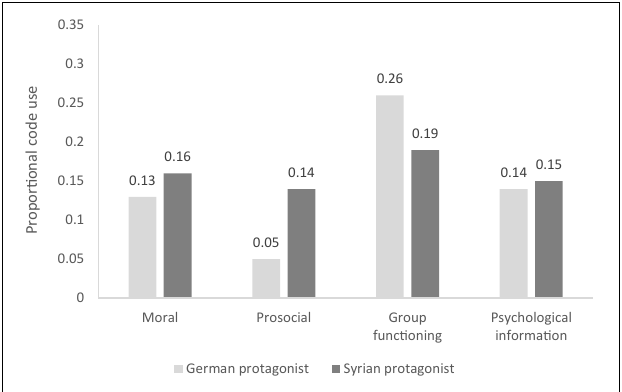
FIGURE 3 | Category use for all three measures across both